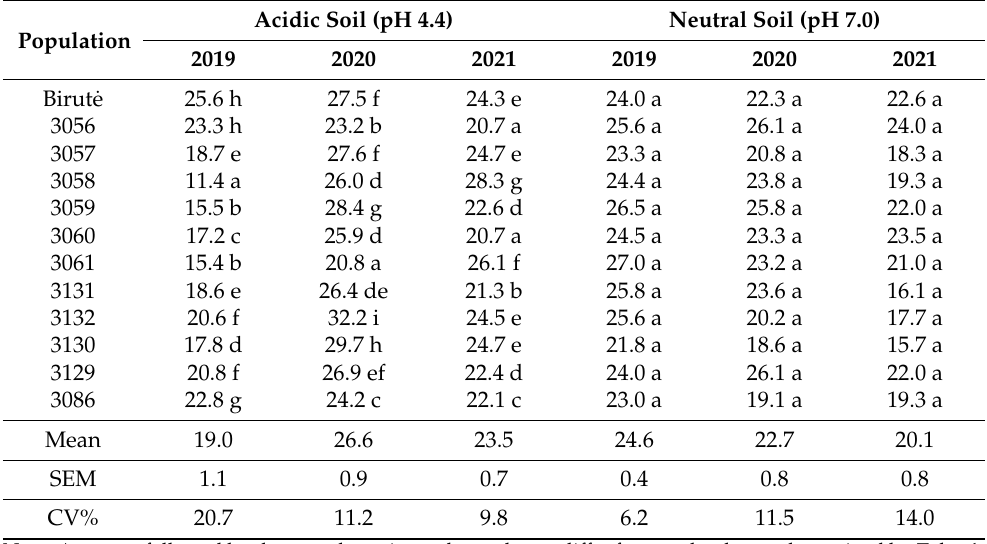
Table 5. The dry matter yield (t ha –1 ) of alfalfa populations at different experimental sites (I and II). Acidic Soil (pH 4.4) Neutral Soil (pH Population